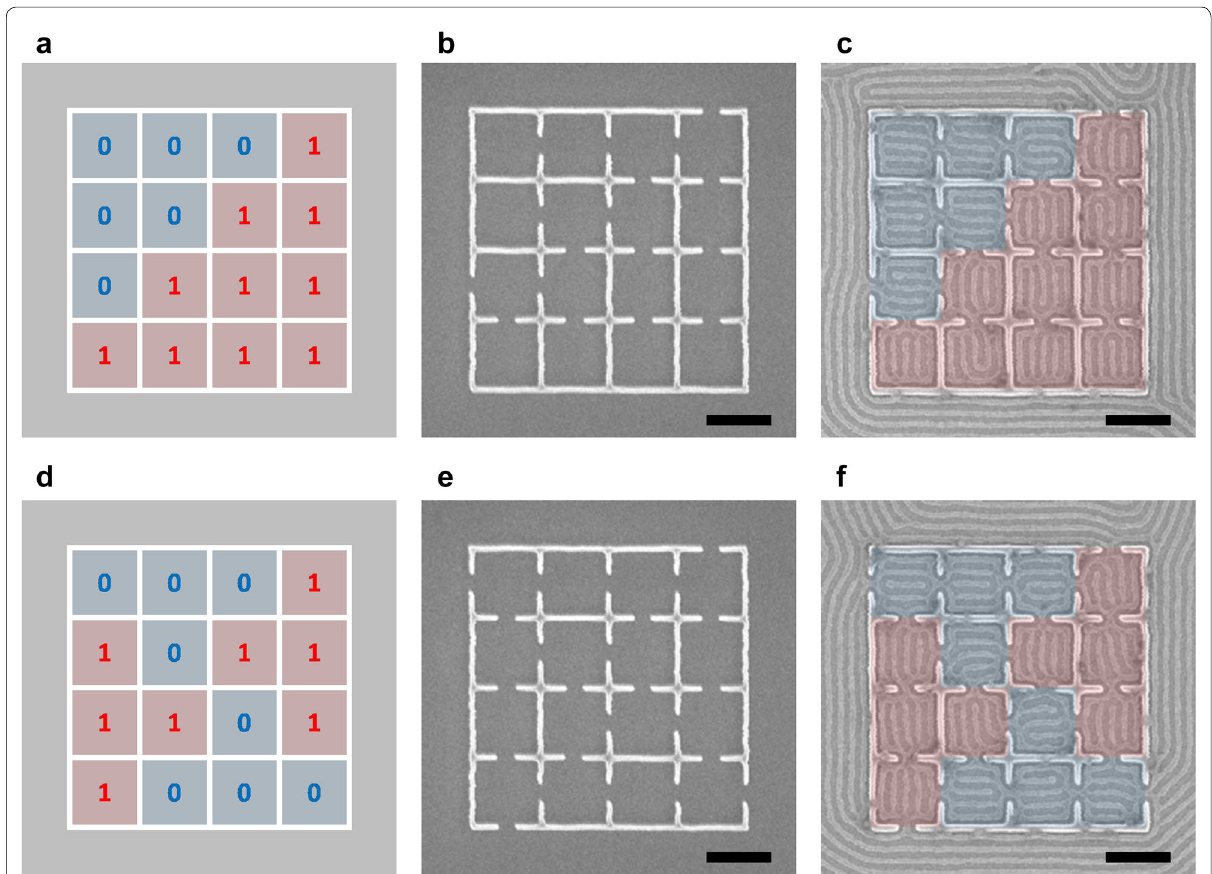
Fig. 6 Fabrication of binary state arrays. a , d Diagram of desired 4 4 binary state arrays. b , e Templates fabricated by electron‑beam lithography. c , × f Resulting block copolymer patterns matching the desired binary states. Red indicates 1 state and blue indicates 0 state. Scale bars, 200